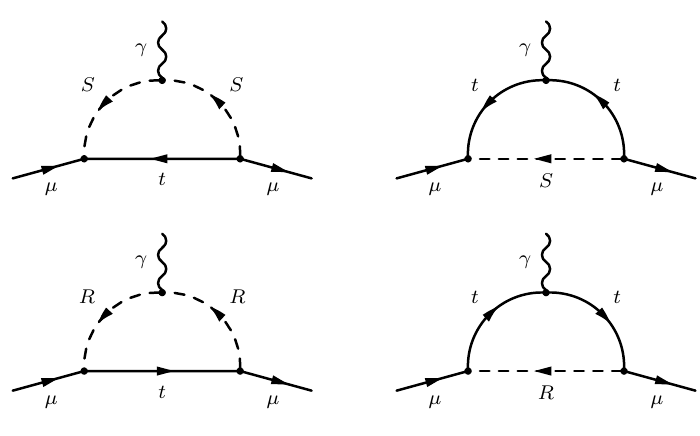
Figure 6 . The one-loop leptoquark contributions to the dipole moment. The upper graphs are from the singlet S 1 and triplet S 3 leptoquarks, and the lower graphs from the doublet R 2